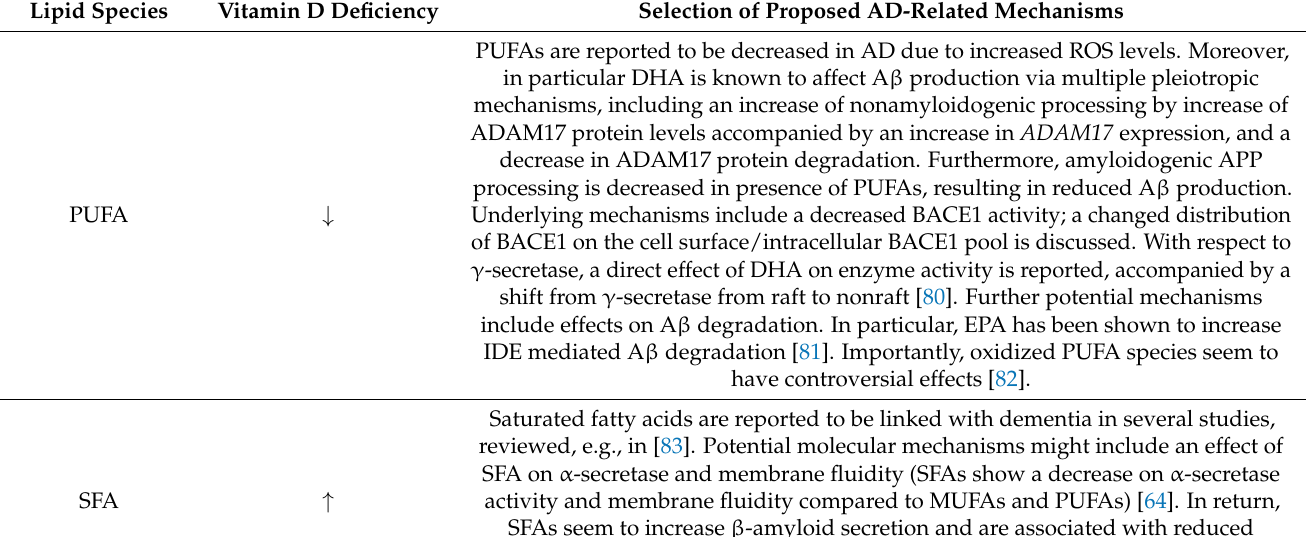
Table 1. Summary of the phospholipids found in this study to be altered under hypovitaminosis D 3 conditions to the known changes in phospholipid homeostasis associated with neurodegenerative Alzheimer’s disease. Lipid Species Selection of Proposed AD-Related